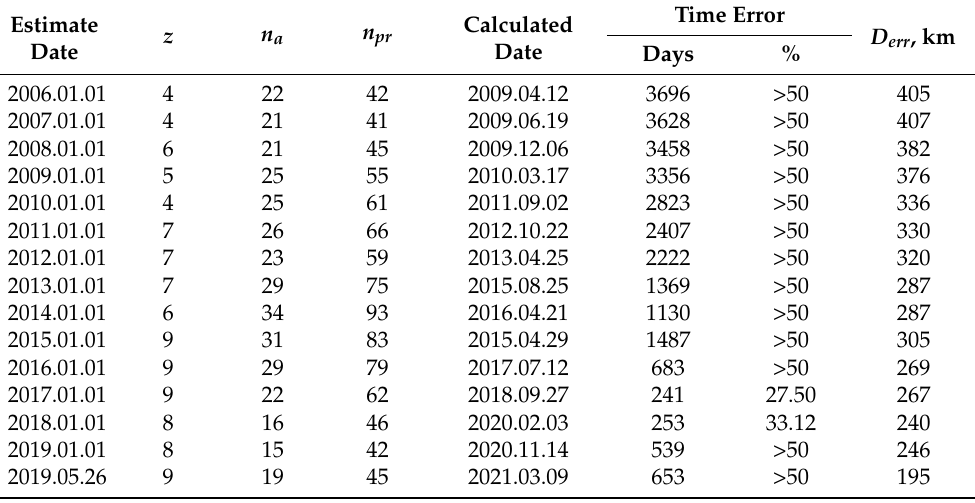
Figure A16. Retro predictability of the earthquake on 26 May 2019 in the zone with the highest (at the estimate date; see Figure A15, column ‘a’) number of successful predictive extrapolations (see Figure A4 for explanations). Table A11. Retro estimation of the place and time of the earthquake on 26 May 2019 by the cluster of its precedent activity.